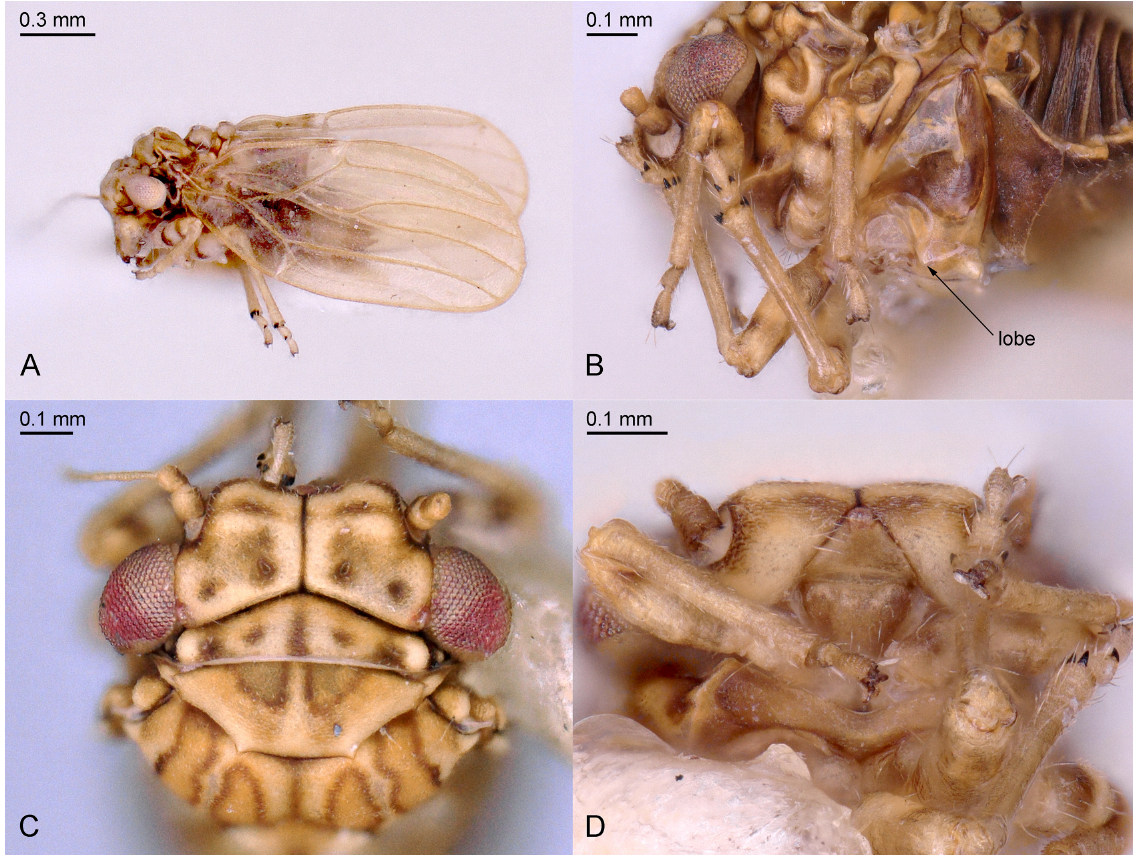
Fig. 2. Microphyllurinae subfam. nov.: Microphyllurus sp. A . Habitus, in profile view. B . Legs. C . Head, dorsal view. D . Head, ventral